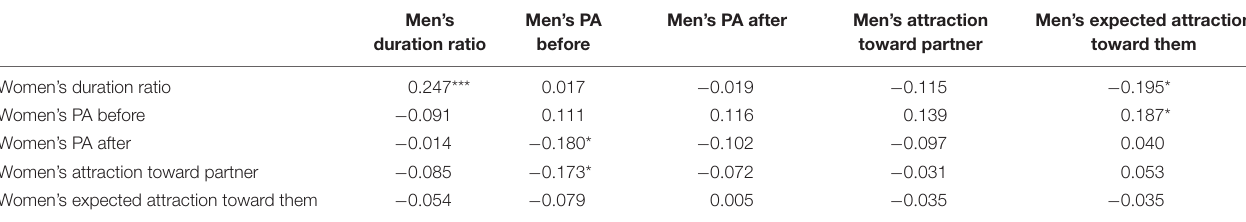
TABLE 6 | Correlations between females and males time perception, perceived attractiveness before and after each date, and attraction felt toward each potential partner.